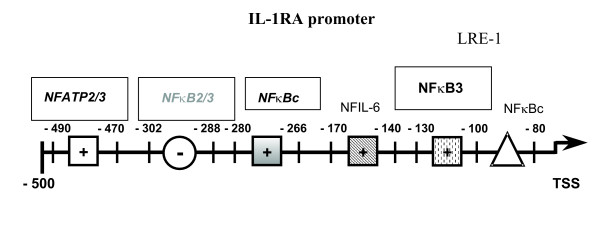
Cartoon of the sense strand of the IL-1RA promoter. Relative locations of previously (LRE-1) [30-33] and newly described (boxed), positively (black) and negatively (gray) regulatory transcription factor binding sites are depicted.